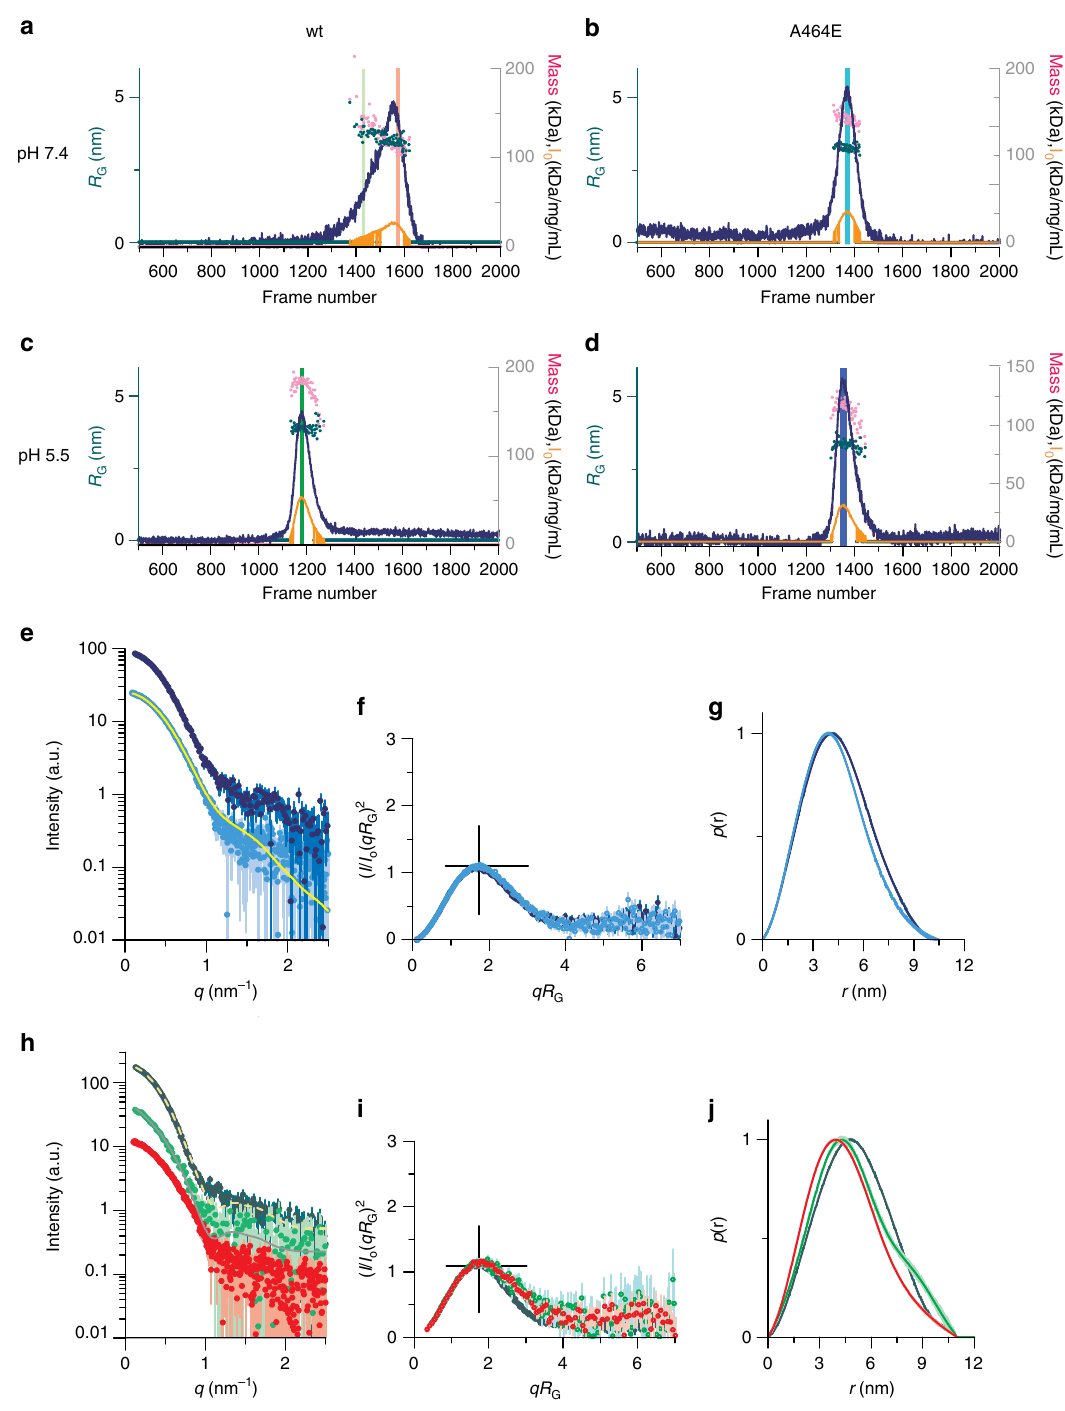
Fig. 5 SEC-SAXS allows identi fi cation of different solution states of s-sortilin. a – d SEC-SAXS chromatograms of wt s-sortilin a , c and s-sortilin A464E b , d at pH 7.4 a , b and 5.5 c , d . The blue lines denote the total summed scattering intensity, orange lines the forward scattering intensity, pink dots the estimated mass based on the correlated volume and green dots the radius of gyration. The boxes denote regions used for subsequent analysis. Light green: dimer at pH 7.4, dark green: dimer at pH 7.4, red and light blue: monomer at pH 7.4, dark blue: monomer. e – g The shape of the s-sortilin monomer is pH dependent. e SAXS curves of s-sortilin A464E at pH 7.4 (light blue, yellow line: coral fi t) and pH 5.5 (dark blue). The curves are shifted by an arbitrary offset for better comparison. f Corresponding normalized Kratky plots. g Corresponding pair distance distribution functions. h – j The shape of the s-sortilin dimer is pH dependent. h SAXS curves of wt s-sortilin at pH 7.4 in monomeric (red) and dimeric state (light green, gray line: CORAL fi t) and pH 5.5 (dark green, yellow line: CORAL fi t). The curves are shifted by an arbitrary offset for better comparison. i Corresponding normalized Kratky plots. j Corresponding pair distance distribution